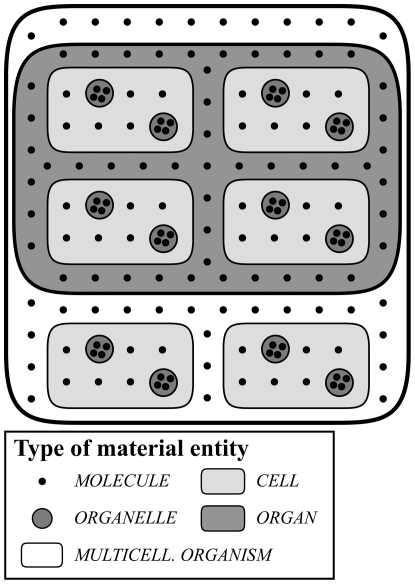
Cumulative Constitutive Granularity.A cumulative constitutive granularity of a multicellular organism consisting of molecules, organelles, cells, and organs. It is characteristic of cumulative constitutive granularities that not all objects belonging to one granularity level are parts of objects at the next coarser level of granularity – they only have to be part of the maximal whole, which is in this case a multicellular organism. Molecules exist that are not part of cells and cells that are not part of organs. As a consequence, the sum of all objects of one level of a cumulative constitutive granularity does not necessarily yield the maximal object.